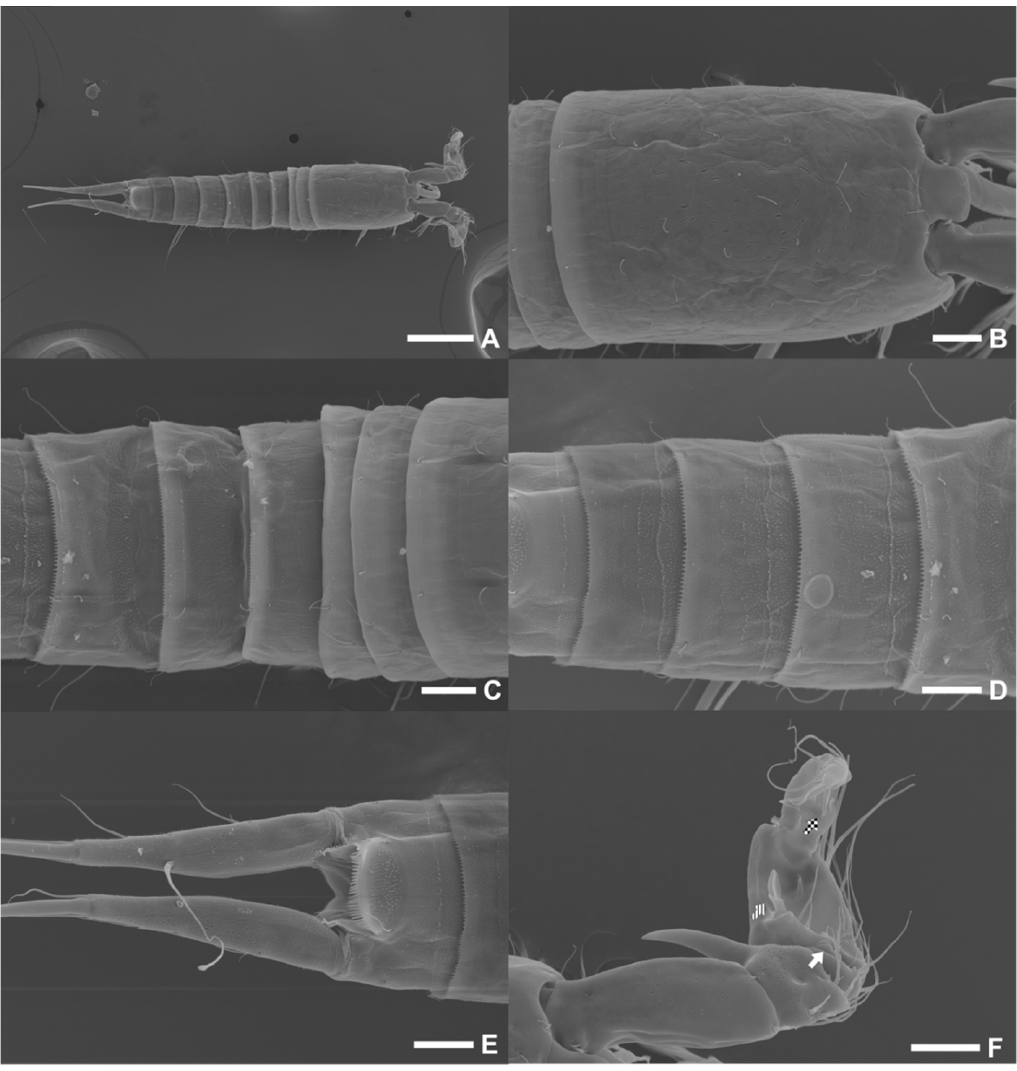
Figure 14. Scanning electron microscopy images of Phyllopodopsyllus saywakimi sp. nov. male (paratype 11) in dorsal view: ( A ) habitus; ( B ) cephalothorax; ( C ) second prosomite to the second uro- somite; ( D ) third to fifth urosomites; ( E ) ana somite and caudal rami; ( F ) antennule. Scale bars: 50 µm.